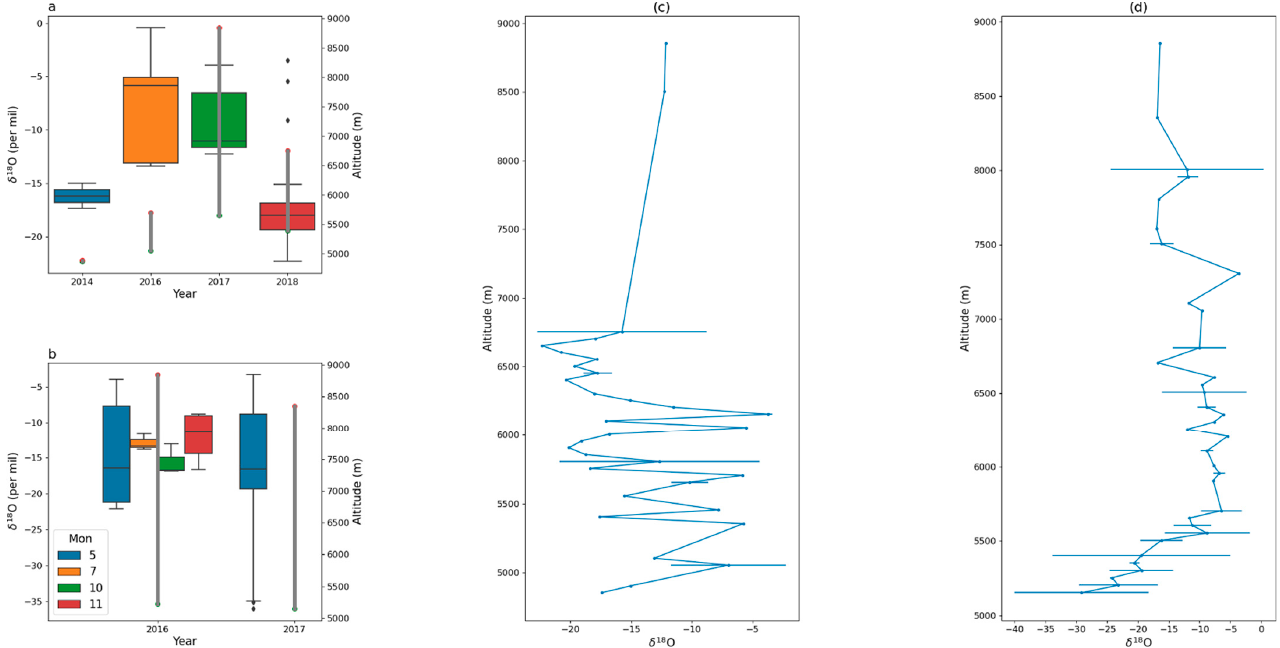
Figure 5. Variation in surface-snow sampling in May during the entire sampling program. ( a ) boxplot of interannual δ 18 O variation (colored) superimposed on sampling elevation ranges (vertical gray bars) for surface-snow samples, ( b ) same as ( a ) but for ice samples, ( c ) vertical profile of surface-snow δ 18 O with error bars in elevation bins, ( d ) same as ( c ) but of ice δ 18 O.